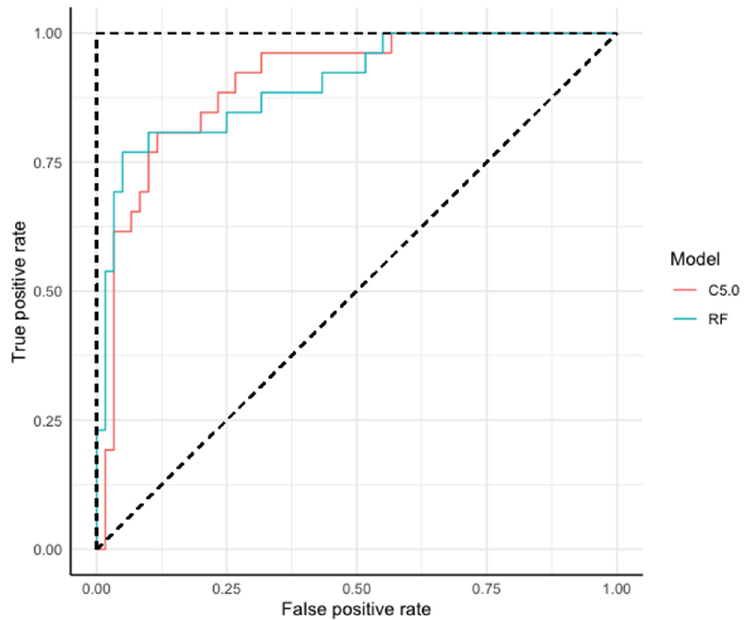
Figure 2. Receiver operating curve (ROC) for comparing the machine learning models random forest (RF) and C5.0 decision tree (C5.0). The broken lines in the ROC curve represent a classifier with no predictive value (diagonal line) and a perfect classifier (horizontal and vertical lines). ROC curves that are closer to the perfect classifier show a better